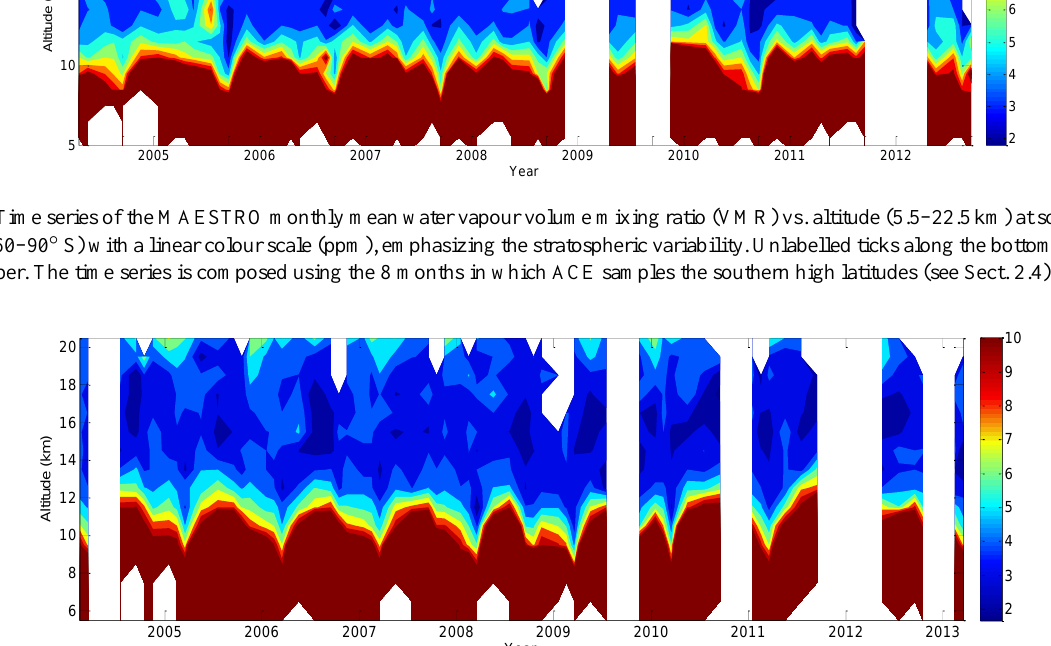
Y ea r Figure 3. Time series of the MAESTRO monthly median water vapour volume mixing ratio (VMR) vs. altitude (km) at northern high latitudes (60–90 ◦ N). The time series is composed using the 8 months in which ACE samples the northern high latitudes (see Sect.